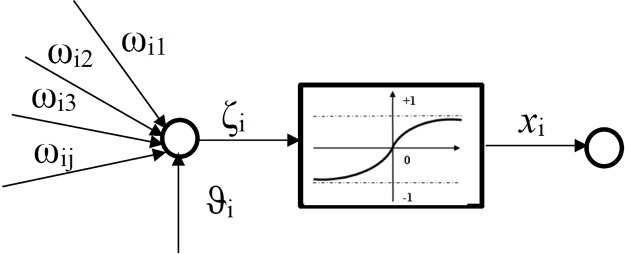
Single-Input Neuron.